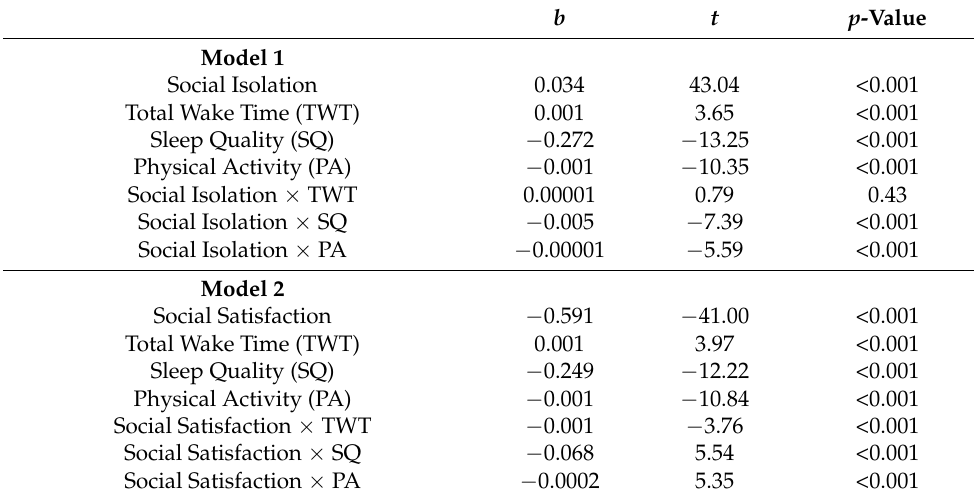
Table 2. Unstandardized model estimates and t-values for the moderation analyses. For both models, all main effects and interaction terms were entered as fixed effects. The dependent variable was depressive symptoms (PHQ-7 scores).